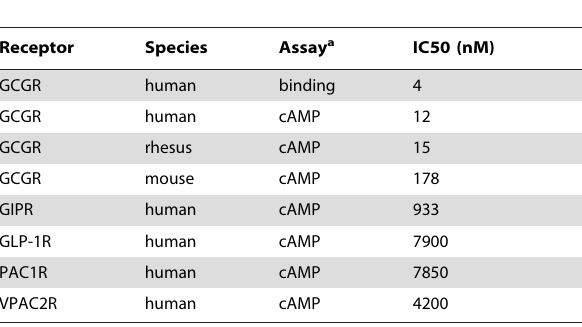
Table 1. Potency and specificity of GRA1 in vitro .